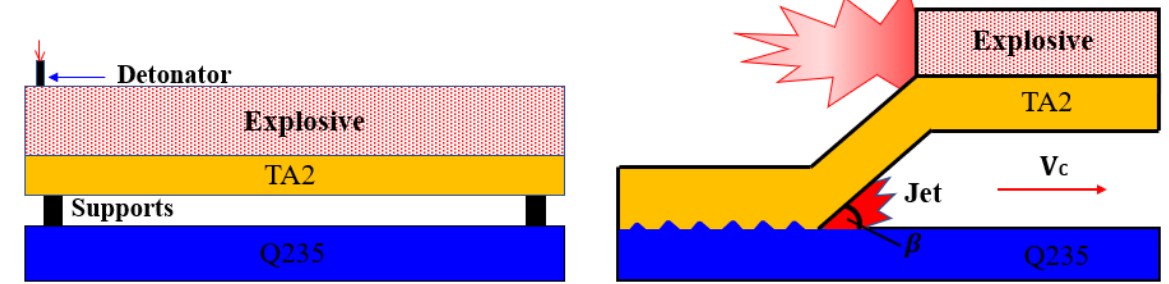
Figure 1. Schematic of the explosive welding device.